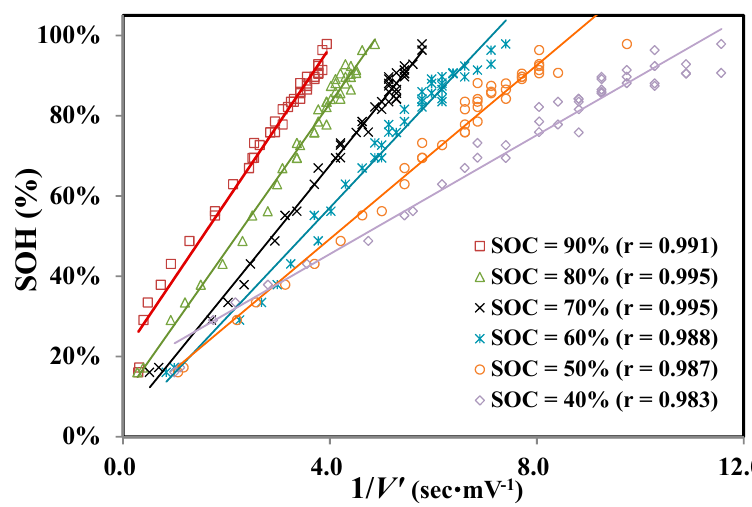
Figure 3. Correlations of SOH to 1/ V ′ at various SOC levels.